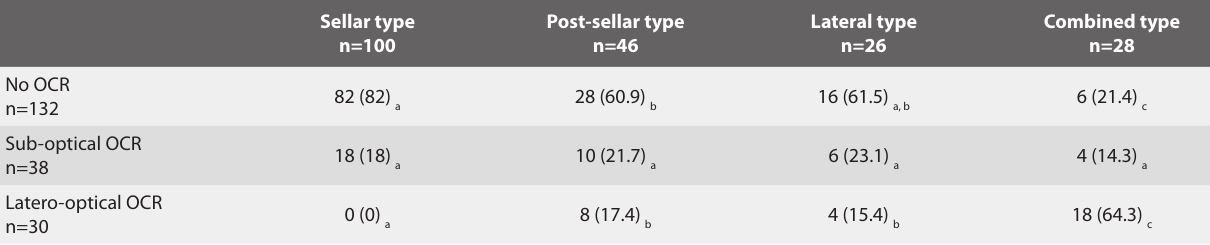
Table 1. Optico-carotid recess results according to sphenoid sinus pneumatization.